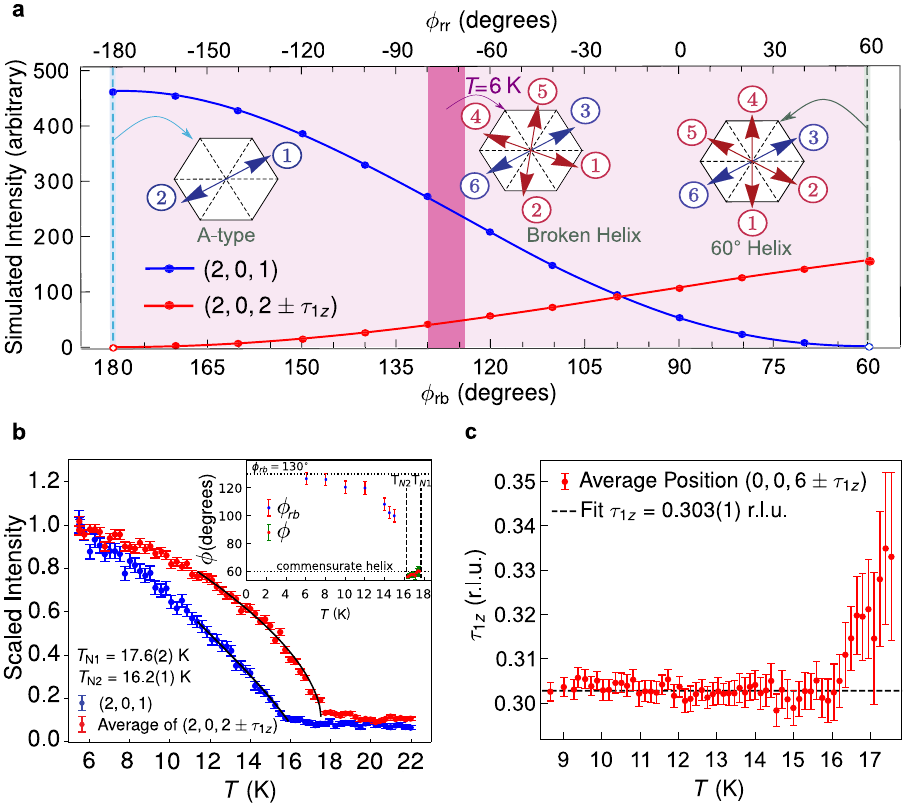
Fig. 2 Details of the broken-helix magnetic order. a Simulations of the magnetic neutron diffraction intensity for the (2, 0, 1) Bragg peak and the average of the (2, 0, 2) ± τ 1 Bragg peaks as functions of the broken-helix turn angles ϕ rb and ϕ rr . b Temperature dependencies of the integrated intensity of the (2, 0, 1) Bragg peak and the average integrated intensity for the (2, 0, 2) ± τ 1 magnetic Bragg peaks measured on the CORELLI spectrometer and scaled to 1 at T = 6 K. The inset displays the helix turn angles ϕ in the pure 60 ∘ -helix phase ( T N2 < T ≤ T N1 ) and ϕ rb for the broken-helix phase ( T ≤ T N2 ). c Temperature dependence of τ 1 = (0, 0, τ 1 z ) from the average of the positions of the (0, 0, 6) ± τ 1 magnetic Bragg peaks. In b , ϕ ( T ) is calculated from the temperature evolution of τ 1 z . ϕ rb ( T ) is calculated from the temperature dependence of the ratio of the integrated intensity of the (0, 0, 5) magnetic Bragg peak to that of the (006) − τ 1 magnetic Bragg peak. These data are from measurements made on the TRIAX spectrometer and are shown in Supplementary Fig.